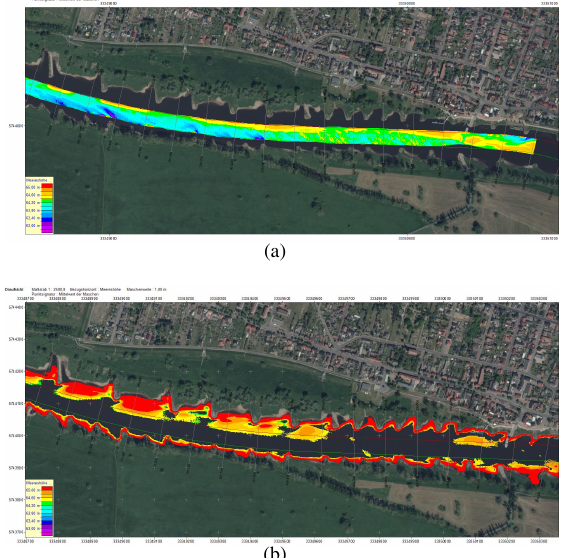
Figure 1. Water bottom points displayed color-coded by their height coordinate of a part of the river Elbe based on (a) echo sounders and (b) ALB measurements.